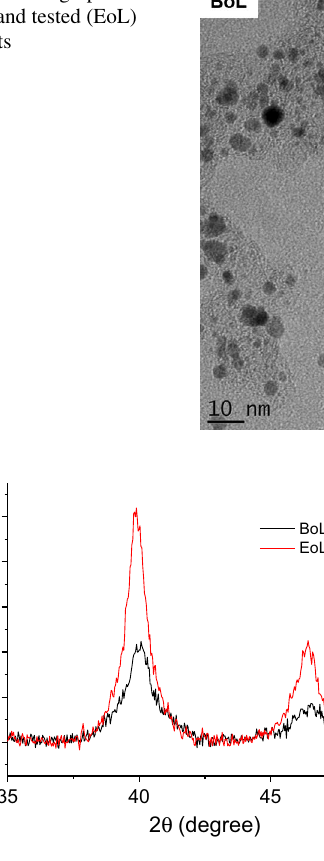
Fig. 8 XRD patterns of cathode before (BoL) and after SU/SD cycling (EoL)